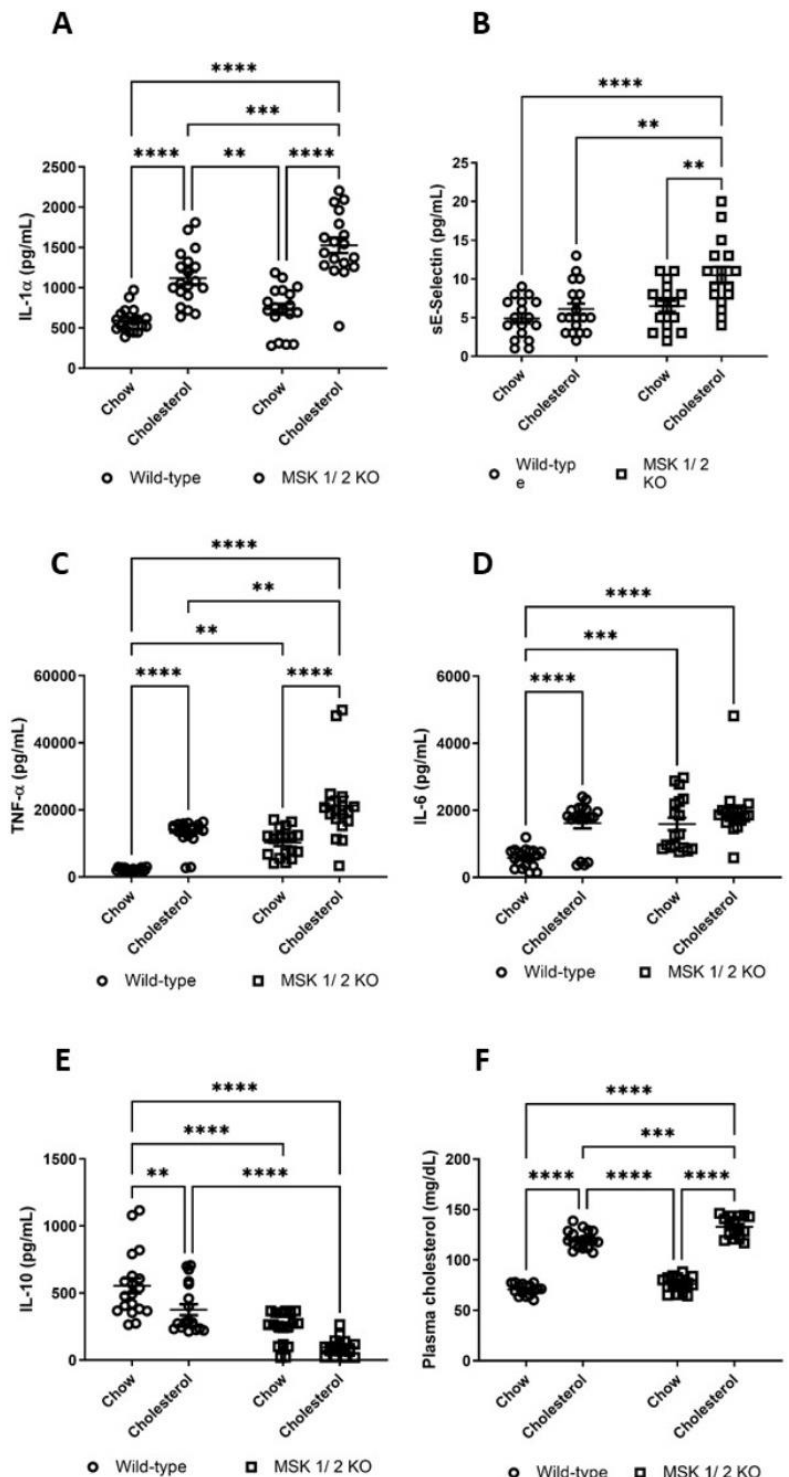
Figure 4. Plasma cytokine and cholesterol measurements in MSK1/2 knockout and wild-type mice. Wild-type (WT)-chow ( n = 19), WT-cholesterol ( n = 19), MSK1/2 knock-out (KO)-chow ( n = 18) and MSK1/2 KO-cholesterol ( n = 18) fed mice (pg/mL). ( A ) IL-1 α , ( B ) sE-Selectin, ( C ) TNF- α , ( D ) IL-6, ( E ) IL-10, ( F ) total plasma cholesterol (mg/dL). Differences between genotype groups were tested using two way-ANOVA followed with post-hoc Bonferroni correction. Values are group means ± SE. ** p < 0.01, *** p < 0.001, **** p <